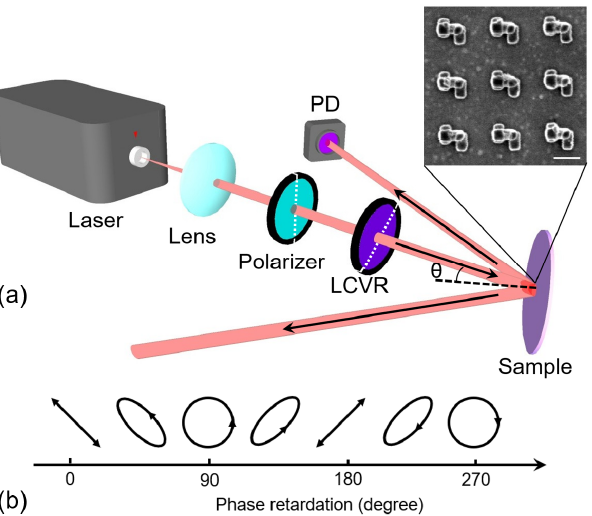
Figure 4. ( a ) The experimental setup to measure the CD from diffracted beams. The incident angle is θ . The power of the diffracted beam was collected using a photodetector (PD). The inset demonstrates the SEM image of the chiral stereo-structure, and the scale bar is 200 nm; ( b ) the evolution of the polarization states of incident beams versus the phase retardation introduced using an LCVR